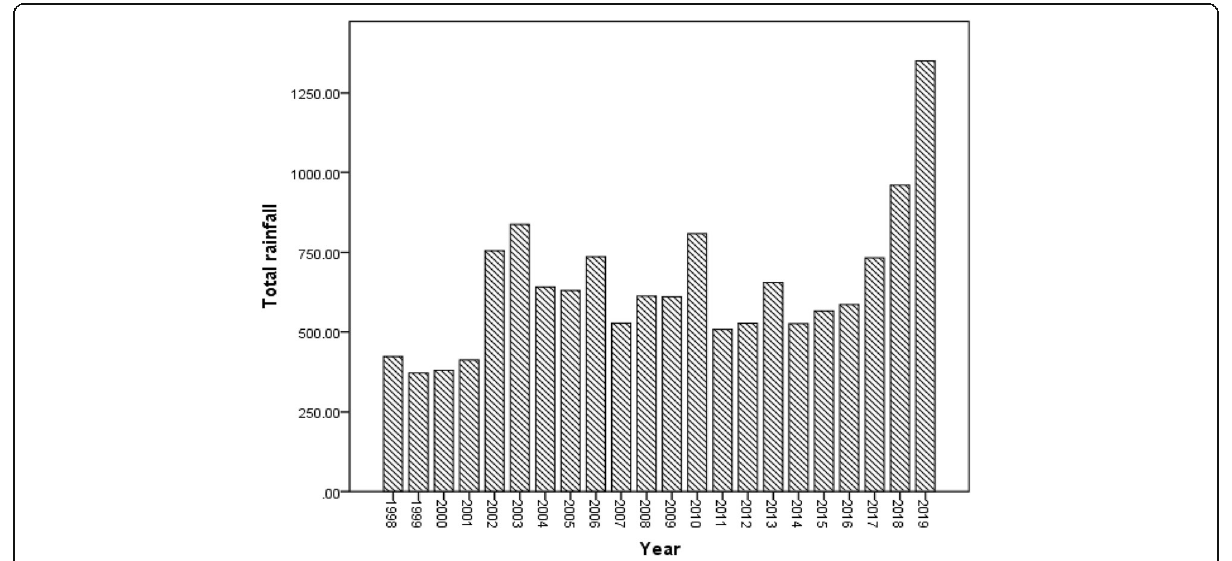
Fig. 3 Annual rainfalls from 1998 to 2019 in the study district